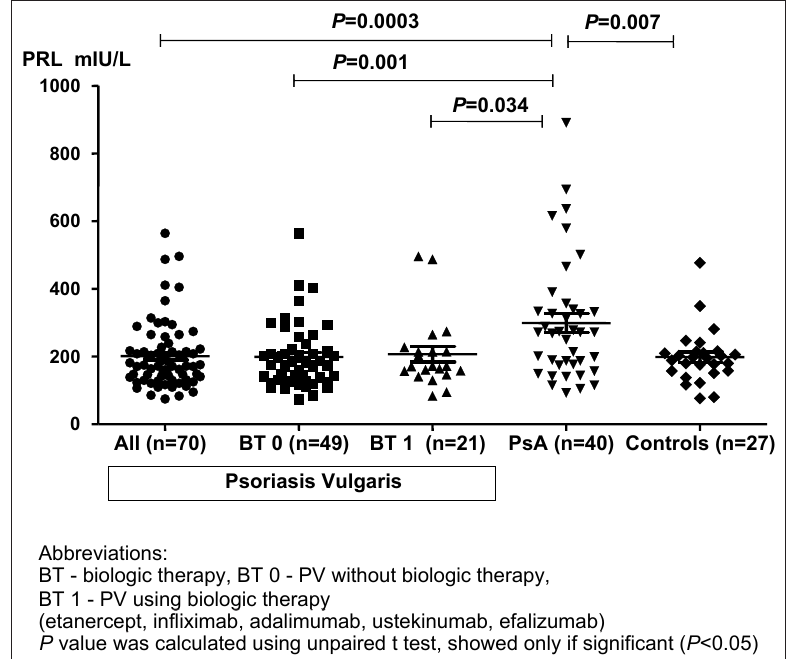
Fig. 1. Differences between serum prolactin (PRL) levels in patients with Psoriasis Vulgaris (PV), Psoriatic Arthritis (PsA) and Healthy Individuals